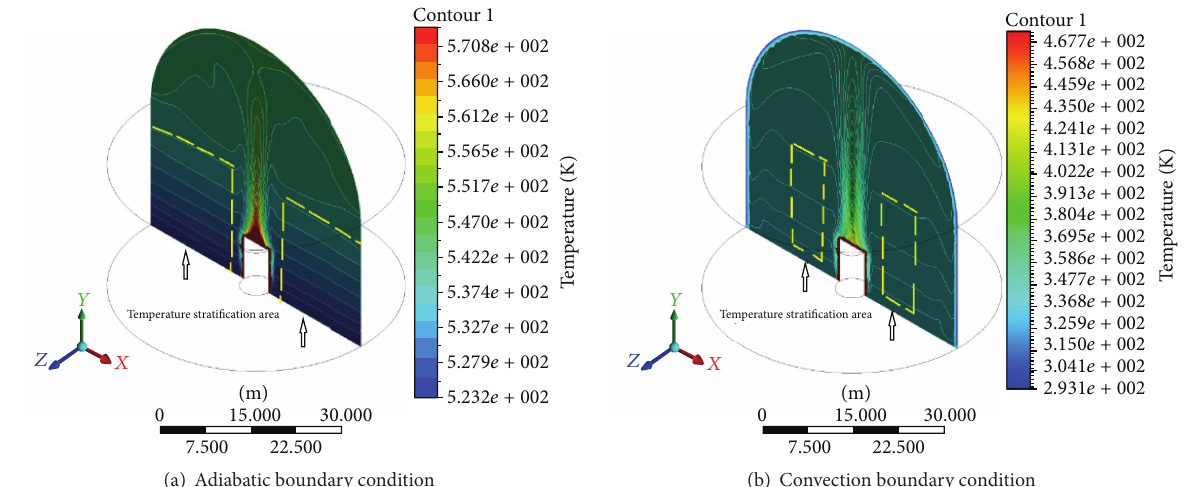
Figure 11: Comparison of thermal stratification